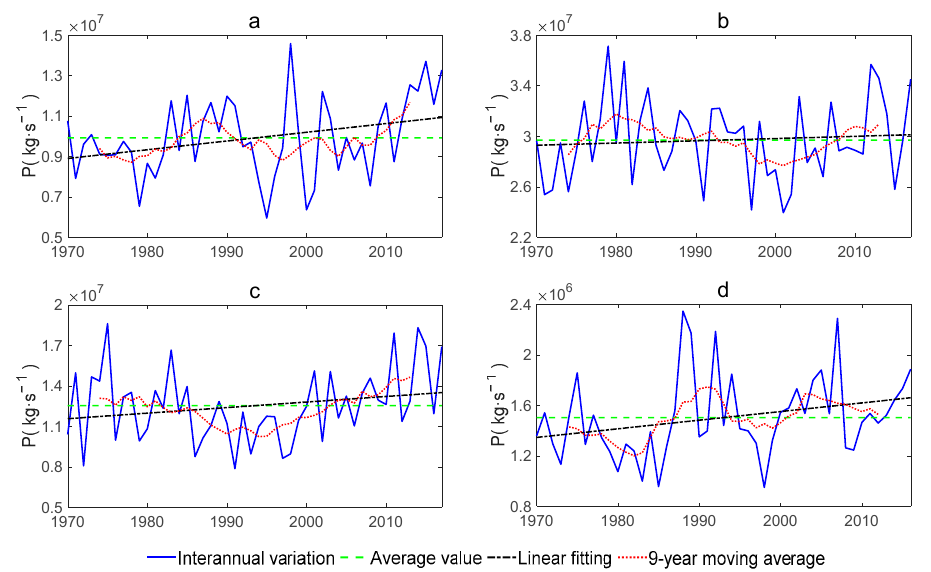
Figure 4. Interannual variation of precipitation in SAIE from 1970 to 2017 in spring ( a ), summer ( b ), autumn ( c ), and winter ( d ).